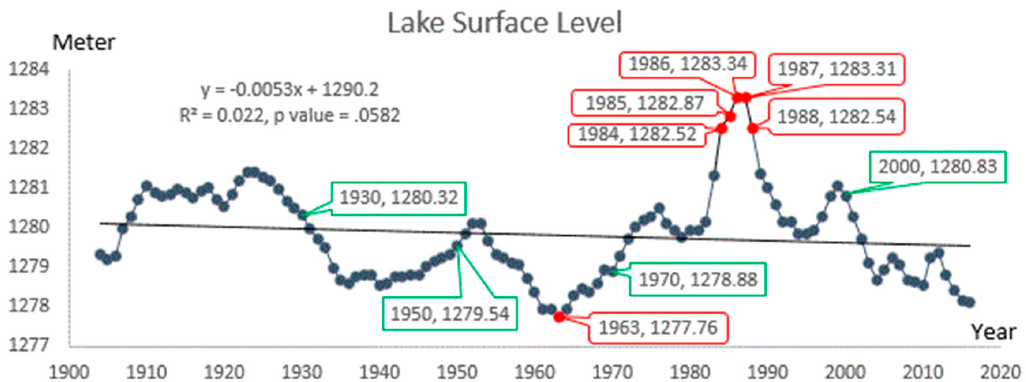
Figure 2. The general declining trend of the GSL surface level and the extremely changing points marked in